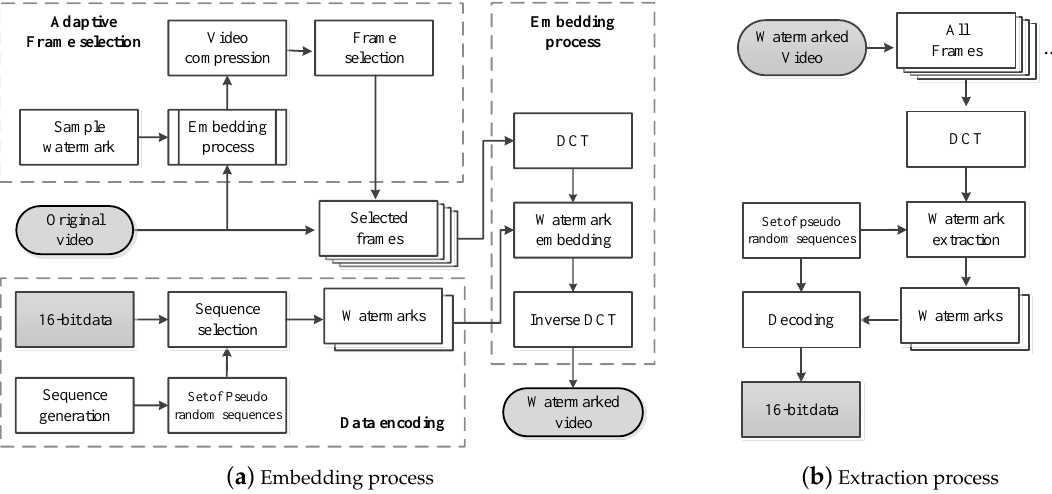
Figure 1. Overall process of the proposed watermarking scheme: ( a ) Watermarking embedding step, and ( b ) extraction